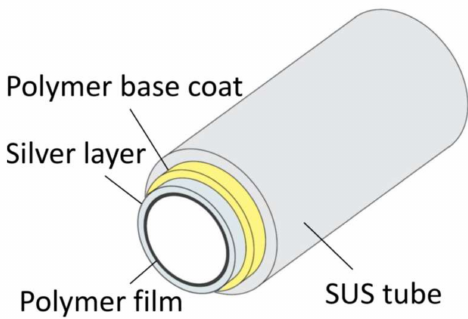
Figure 1. Schematic structure of the stainless-steel (SUS)-based hollow optical